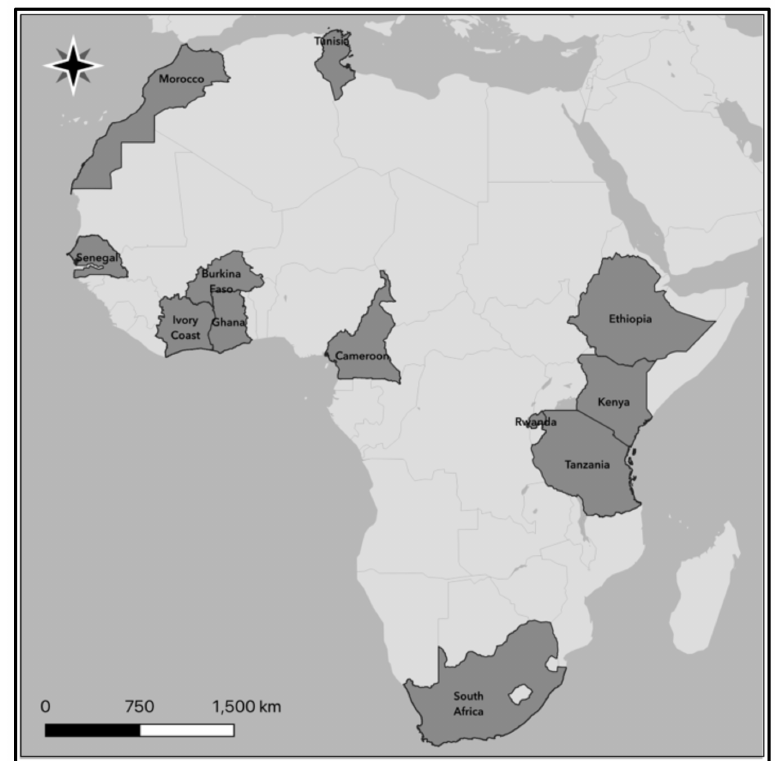
Figure 1. Map showing the 13 African countries investigated (dark grey color) in this